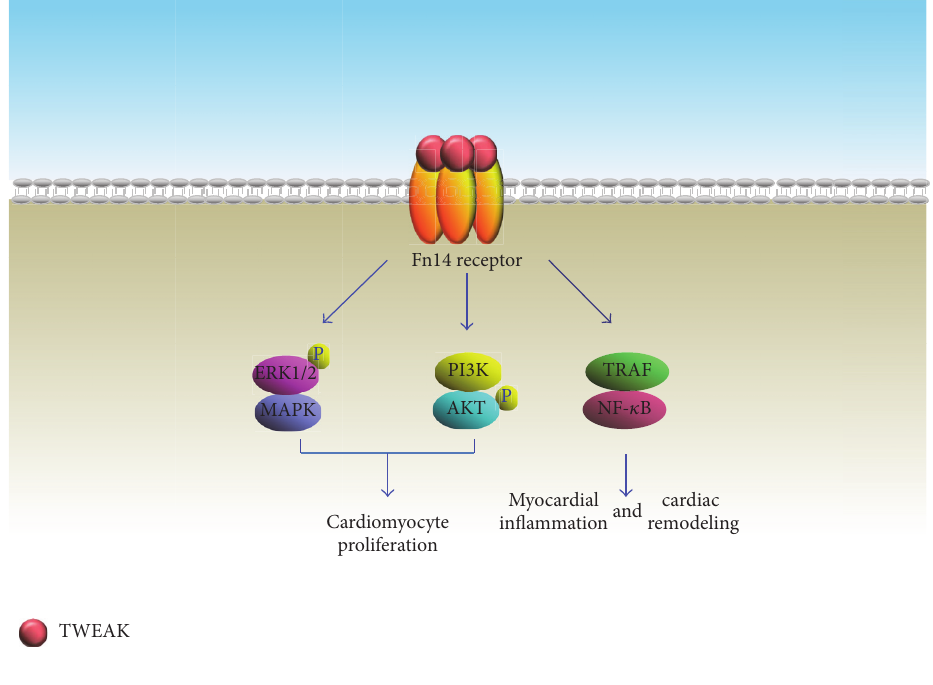
Figure 4: Involvement of TWEAK-Fn14 signaling pathways in cardiac